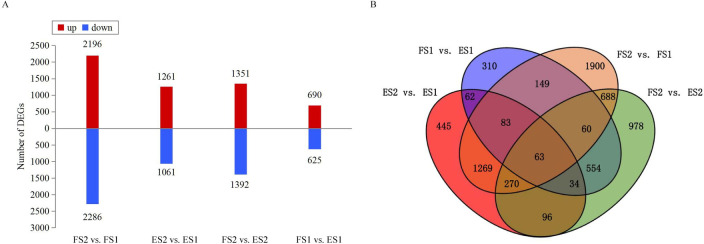
DE mRNA analyses.(A) Numbers and levels of DEGs in the four comparisons. (B) Venn diagram of DE mRNAs among the four comparisons.